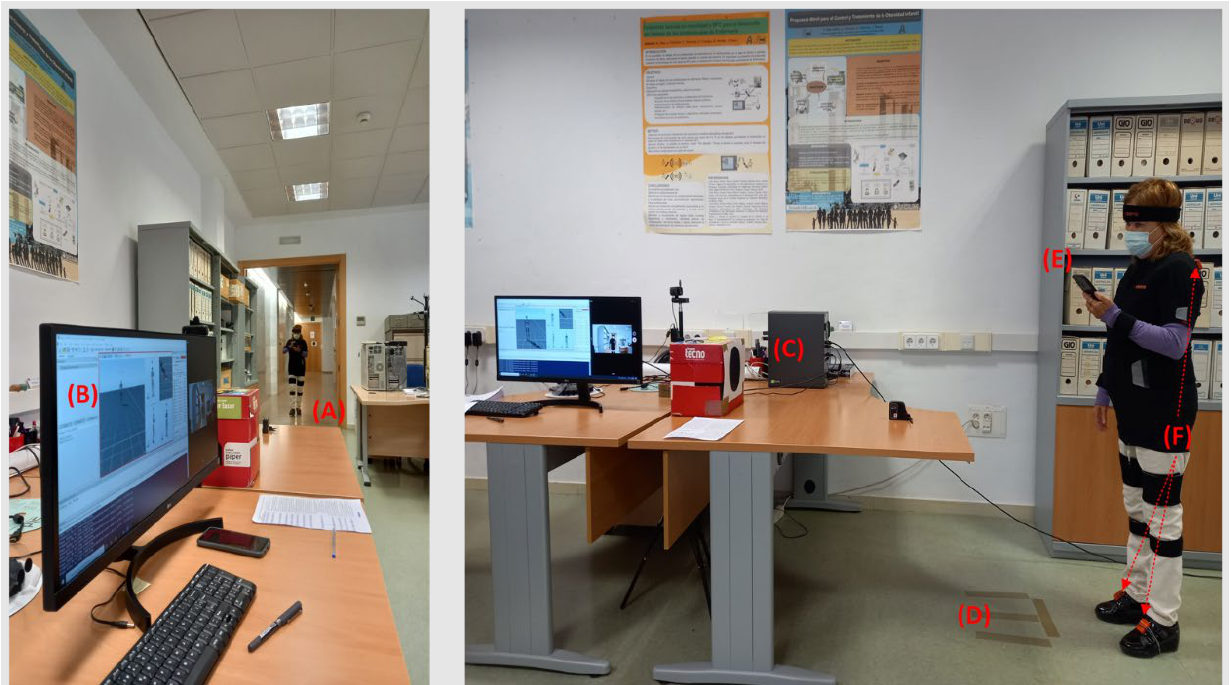
Figure 2. Instrumentation and experiment environment. (A) 24-m-long corridor the participants must walk. (B) Monitor where the movement of the person is visualized in real time. (C) Computer with motion capture software. (D) Start position marks. (E) Personal mobile device. (F) Some of the MTw IMUs.